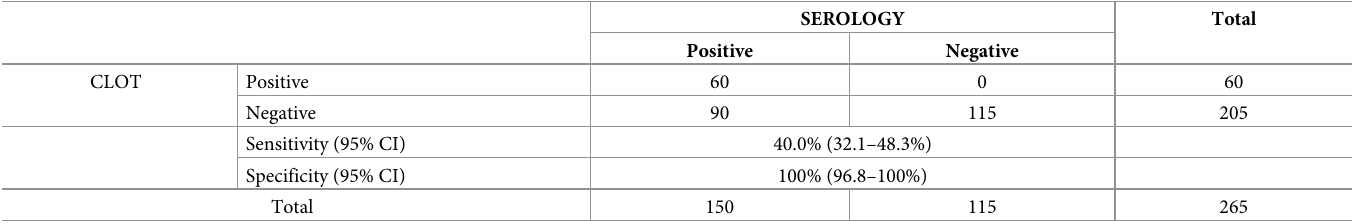
Table 2. Comparison of qPCR to serology using DNA extracted from clot.